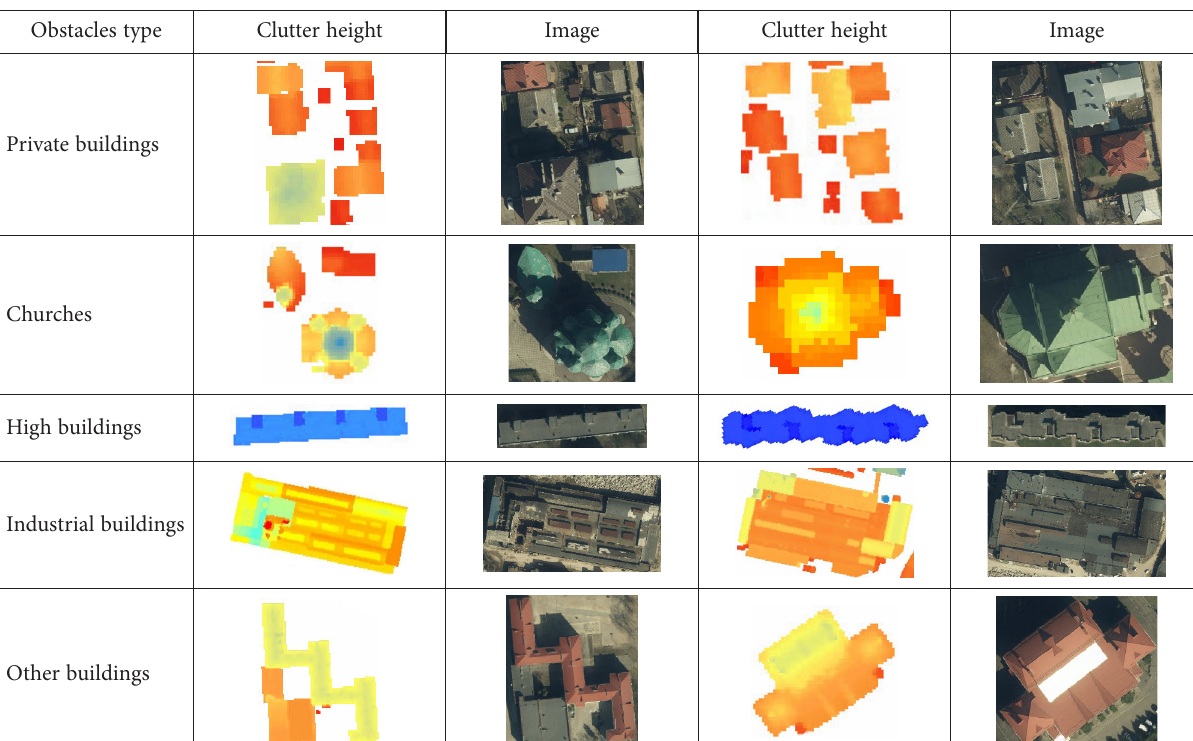
Table 1. Clutter height examples for buildings